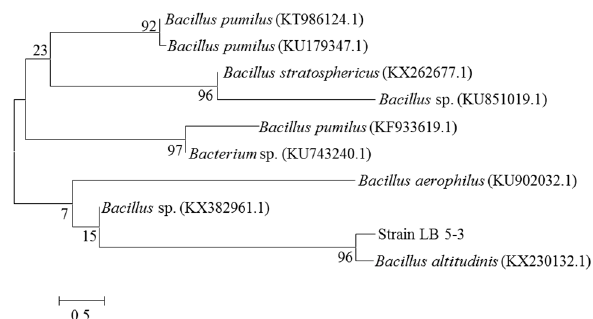
Figure 2. Phylogenetic tree based on 16S rDNA gene sequences showing the phylogenetic relationships between endophyte LB 5-3 and related species.